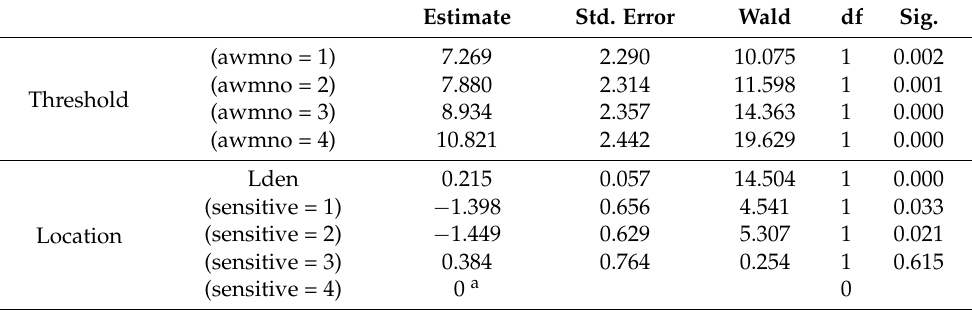
Table A2a. Estimated parameters of the relationship between noise exposure (L den ) and wind turbine noise annoyance outside dwelling, with control for noise sensitivity. n = 86.